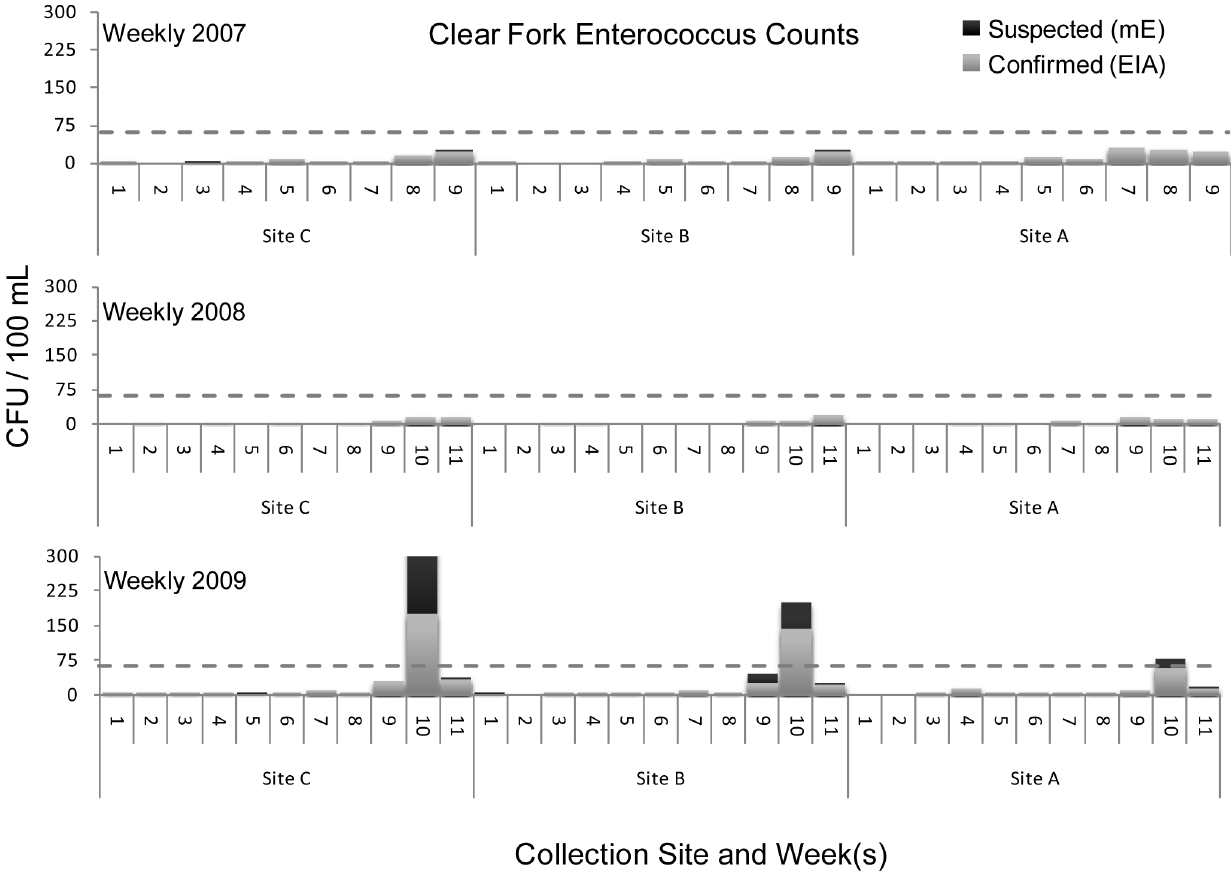
Figure 6. Clear Fork Enterococcus counts.